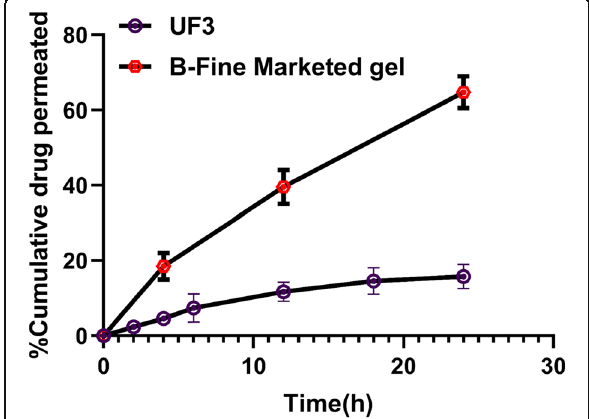
Fig. 6 In vitro skin permeation of optimized UF3 and B-Fine marketed gel. Values are articulated as mean ± SD ( n = 3)